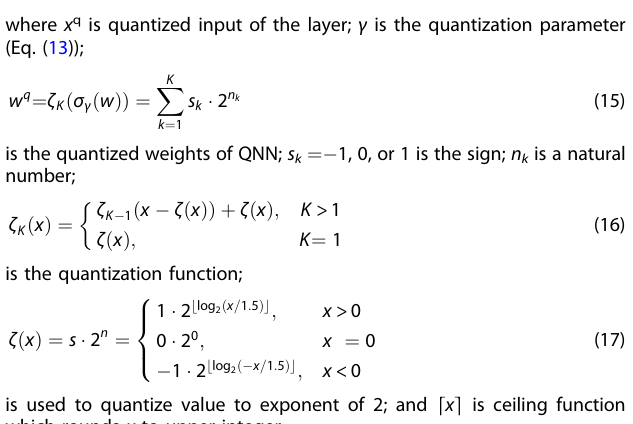
Fig. 10 The comparison between two activation functions. The normalized ϕ ( x ) is close to tanh( x ) at the numerical value and fi rst